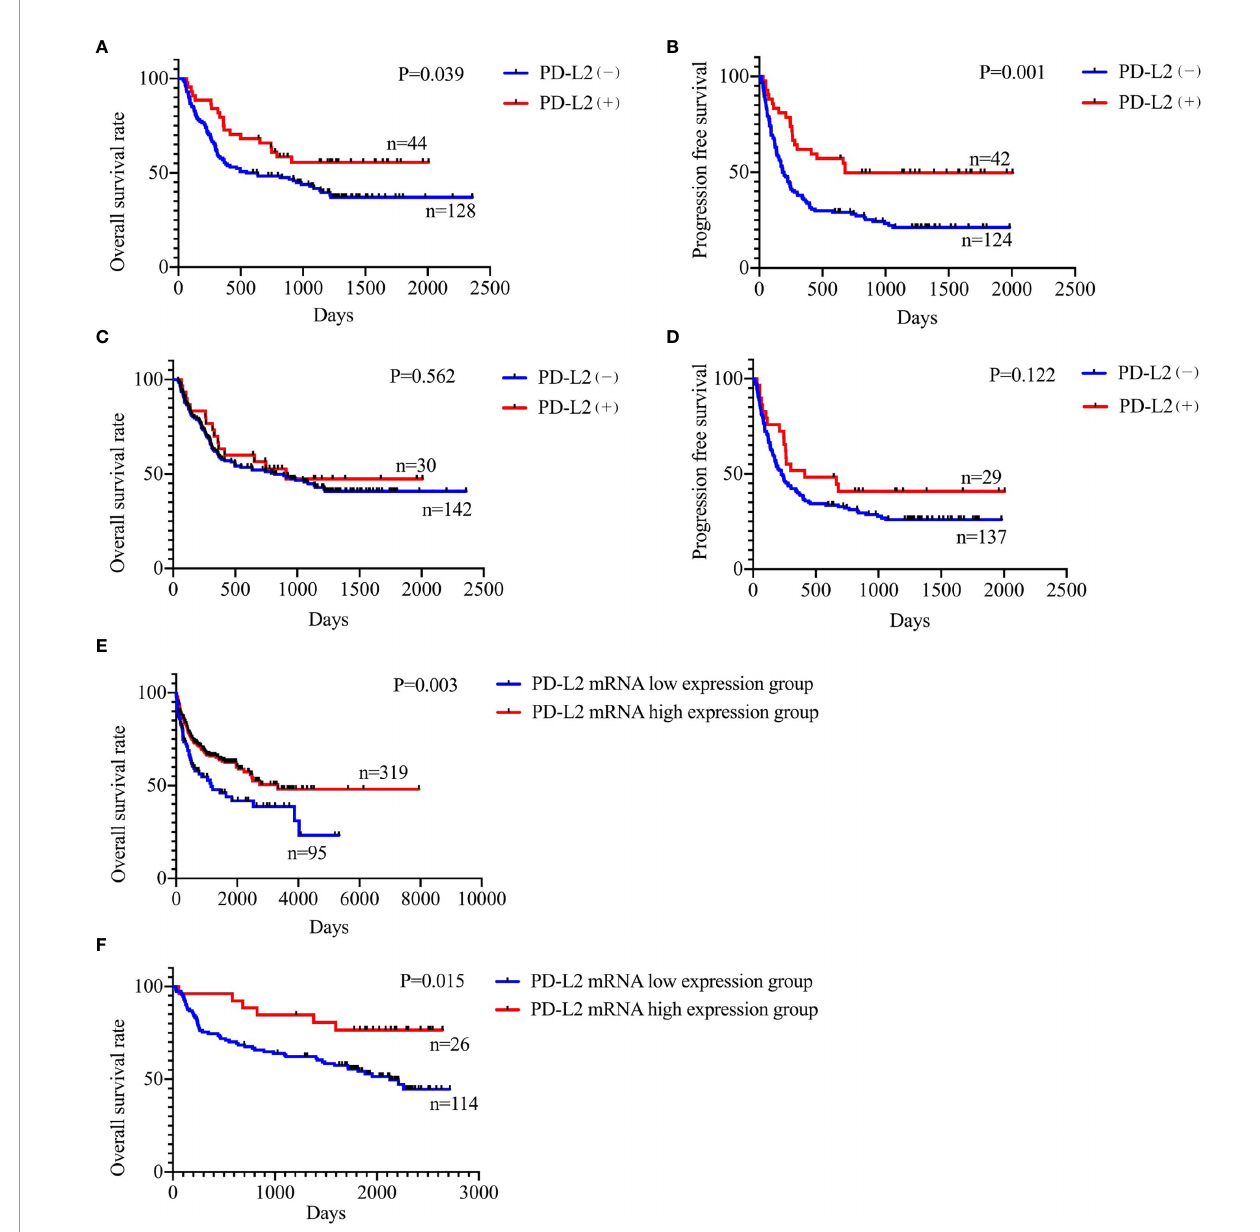
FIGURE 2 | Relationship between TC PD-L2 (+) and overall survival (A) and progression free survival (B) curves. Relationship between IC PD-L2 (+) and overall survival (C) and progression free survival (D) curves in newly diagnosed diffuse large B-cell lymphoma. Relationship between PD-L2 mRNA level and overall survival of DLBCL. (E) GSE10846, (F)